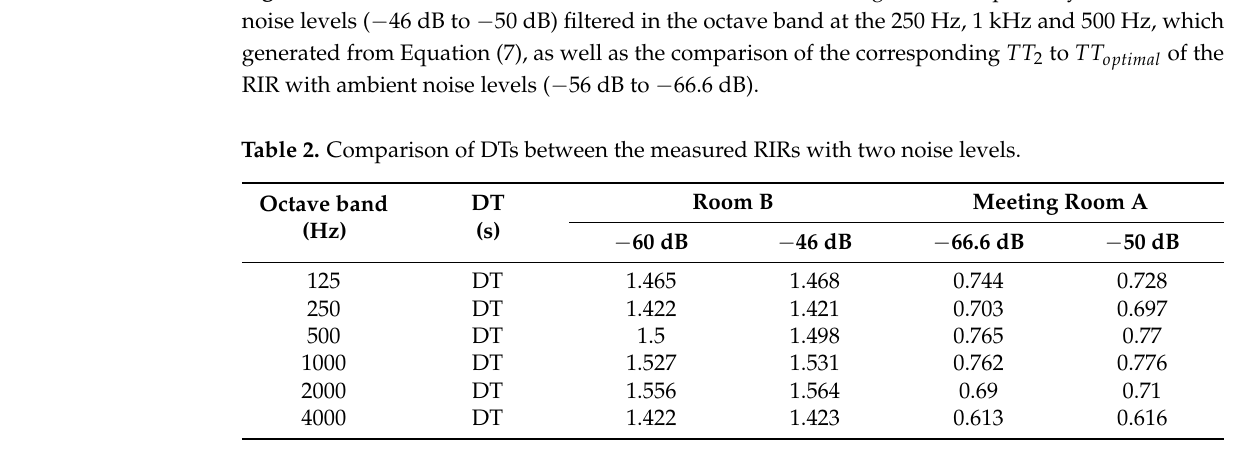
Table 2. Comparison of DTs between the measured RIRs with two noise levels.